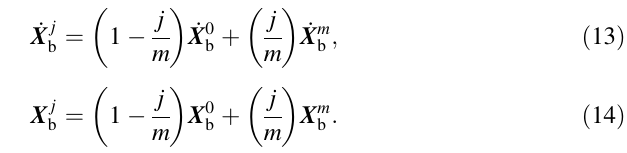
Fig. 4. The three towers with 157 m in height are inverted with 158 cables. The ballast track structure is laid on the bridge deck, which is stiffened by U-shape and T-shape stiffeners and the main girder on each side, as shown in Fig. 5b. The 3D finite element model of the cable-stayed bridge is presented in Fig. 6. The rails, sleepers, piers, and towers are modeled using beam elements based on the actual cross-sectional properties. Distributed uniaxial spring–dashpot units are used to simulate the elasticity behavior of the ballast and fasteners. Based on the equiv- alent orthotropic material modeling method presented by Cai [33], the equivalent shell element is used to model the bridge deck with U-shaped and T-shaped stiffeners. Each